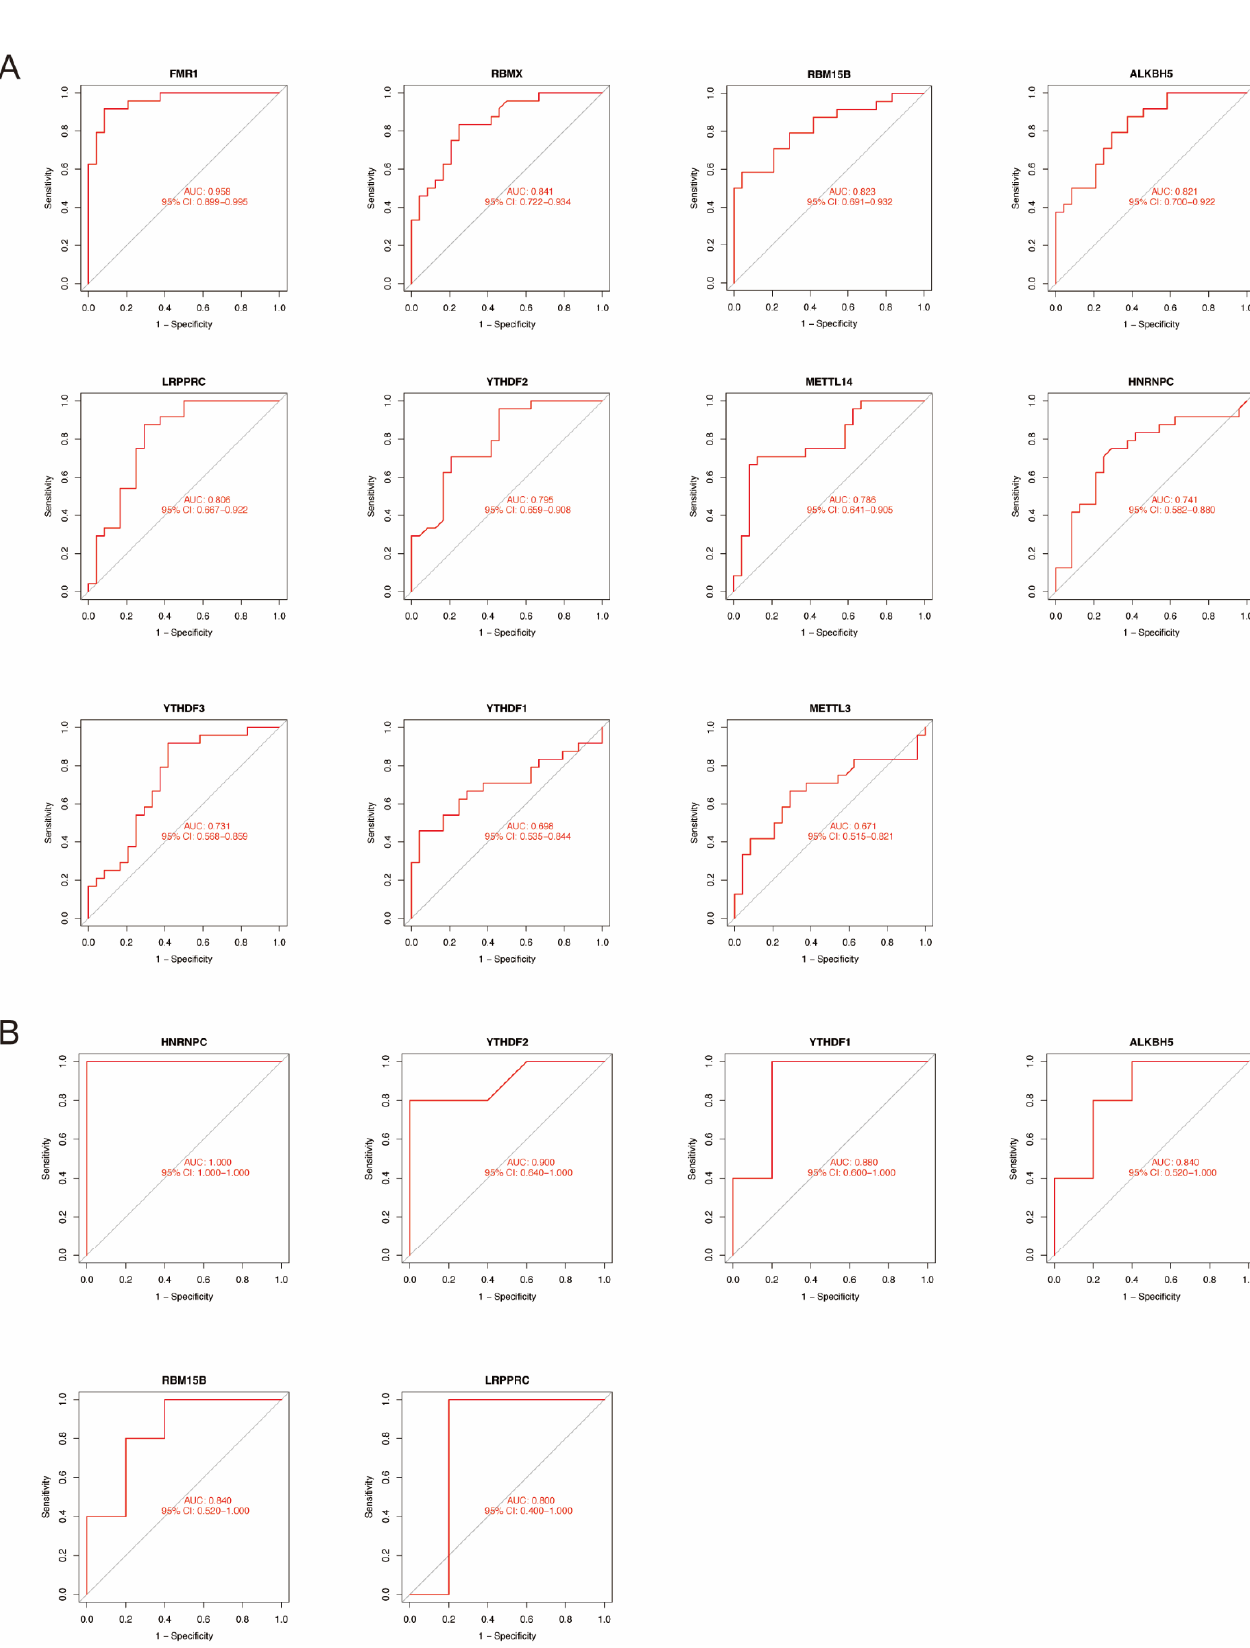
Figure 4. Construction of ROC curves. ( A ) ROC curves of significant genes based on GSE165004. ( B ) ROC curves based on GSE26787.